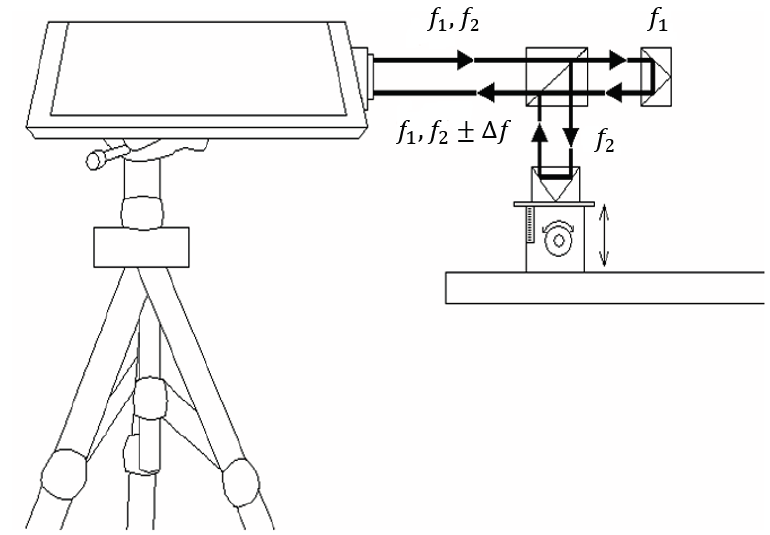
Figure 11. A schematic of a laser